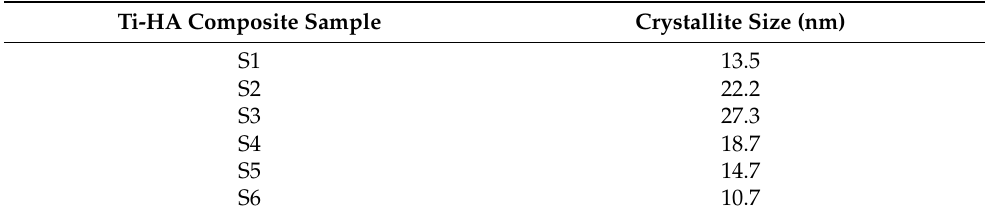
Table 2. Mean crystallite size of the Ti:HA composite. Ti-HA Composite